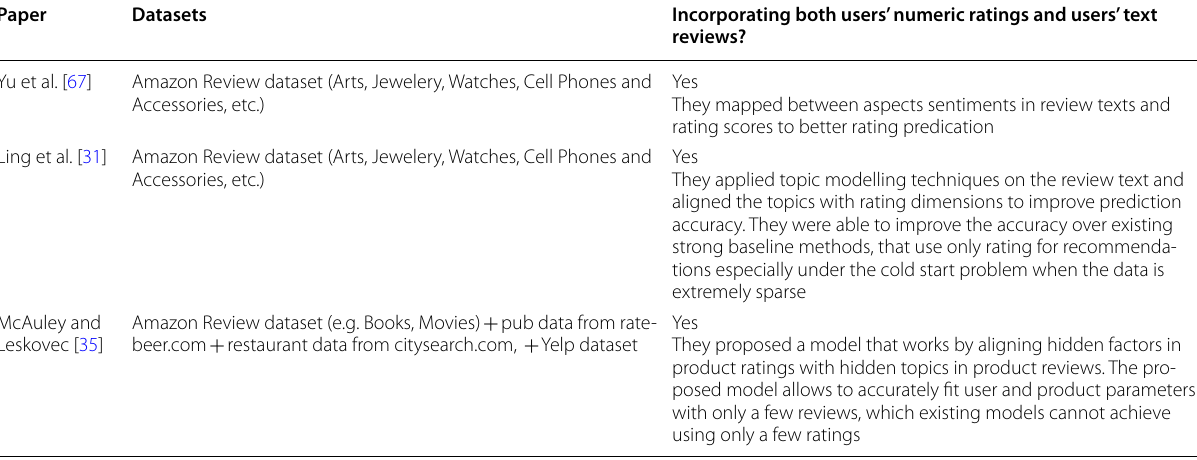
Table 3 Summary of the reviewed papers which incorporate both numeric ratings and texts reviews in recommendation